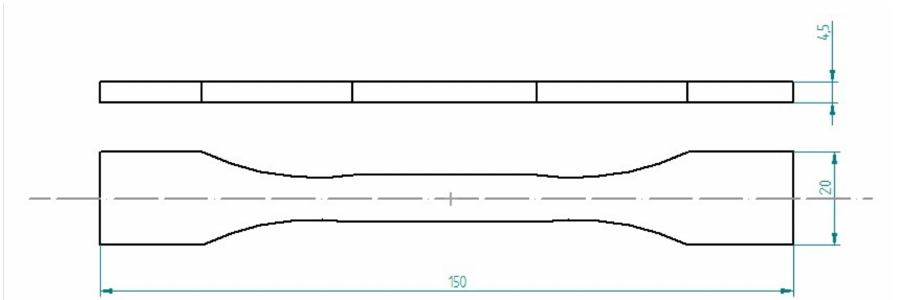
Figure 3. Dimensions of a dog-bone